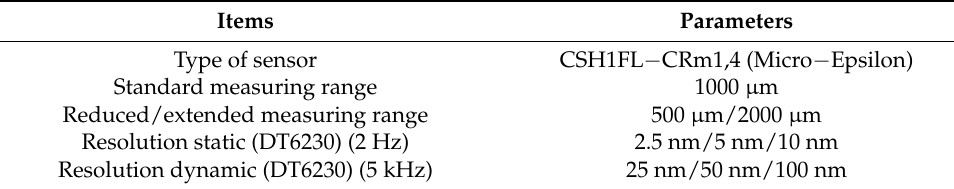
Table 3. The main parameters of the capacitive displacement